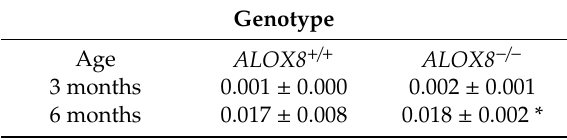
Table 1. Residual M gene RNA levels in the lungs of influenza-infected mice at 10 days after inoculation. †